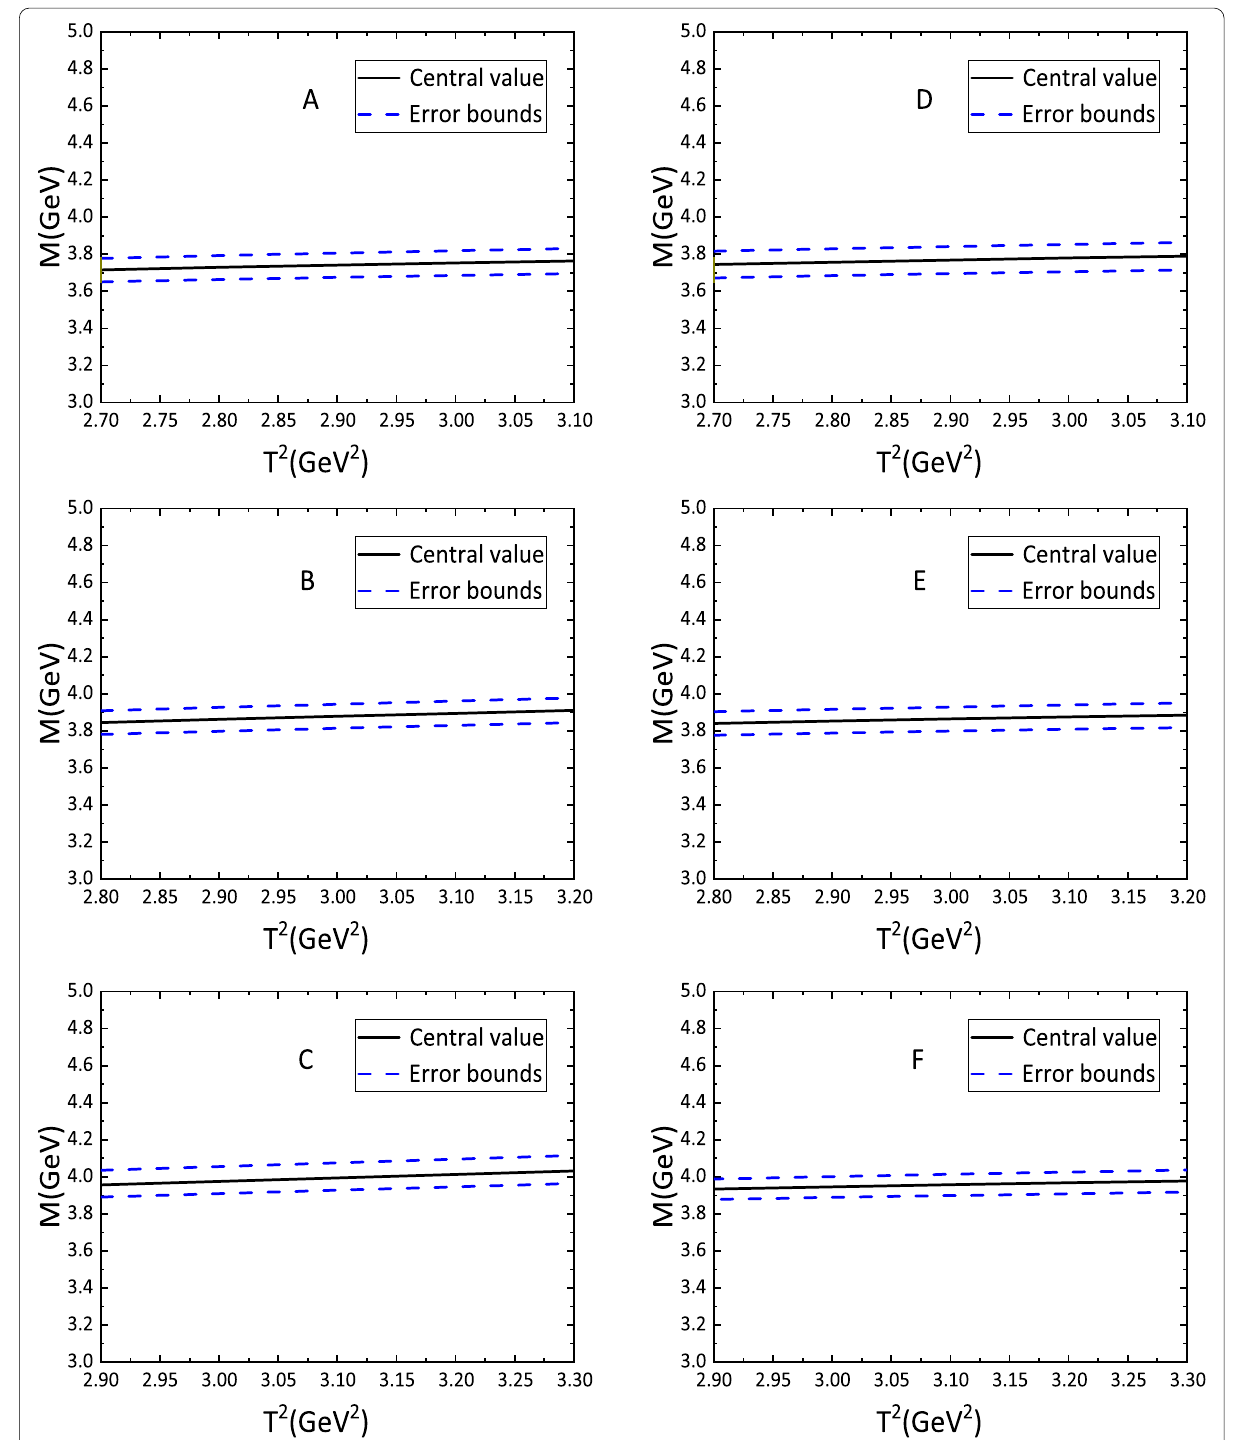
Fig. 2 The masses with variations of the Borel parameters, where the A , B , C , D , E , and F denote the D ¯ D , D ¯ D s , D s ¯ D s , D D , DD s , and D s D s molecular states,